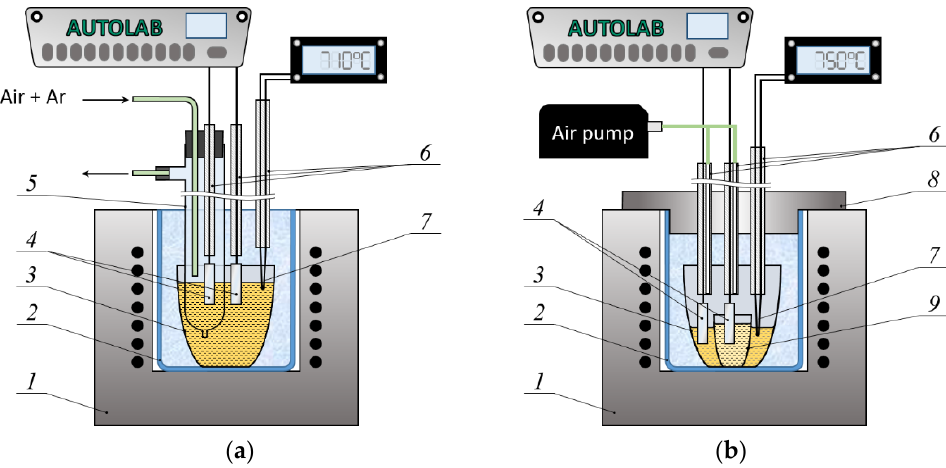
Figure 1. Schemes of experimental setups ( a ) for determining the effect of oxygen partial pressure on the potential of the Pt electrode and ( b ) for measuring the dependence of Δ E on the mole fraction of WO 3 in the melt. Designations: 1 —shaft furnace, 2 —quartz protective vessel, 3 —platinum crucible with the 0.8Na 2 WO 4 –0.2WO 3 melt (standard melt), 4 —Pt electrodes, 5 —quartz test tube, 6 —alumina tubes, 7 —Pt/Pt-Rh thermocouple, 8 —stainless steel lid filled with kaolin wool, 9 —thin-walled alumina crucible with the melt under study.